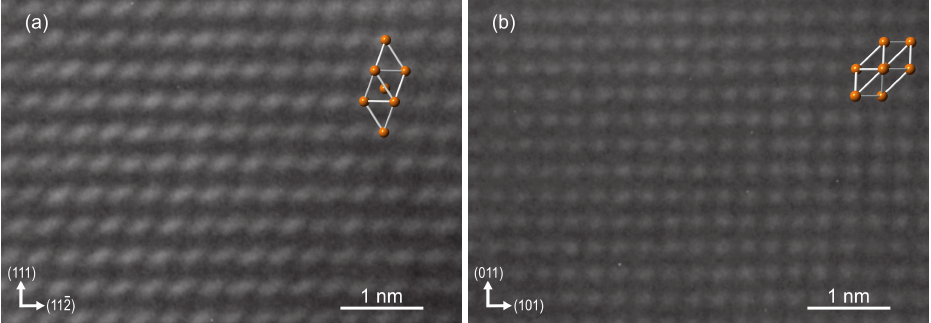
Figure 7. High-resolution TEM micrographs of samples S10 ( a ) and S11 ( b ) with superimposed Bi lattice models. Determined zone axes of the Bi layer are [110] and [111] for S10 and S11, respectively. The Si substrate zone axis was determined as [110].